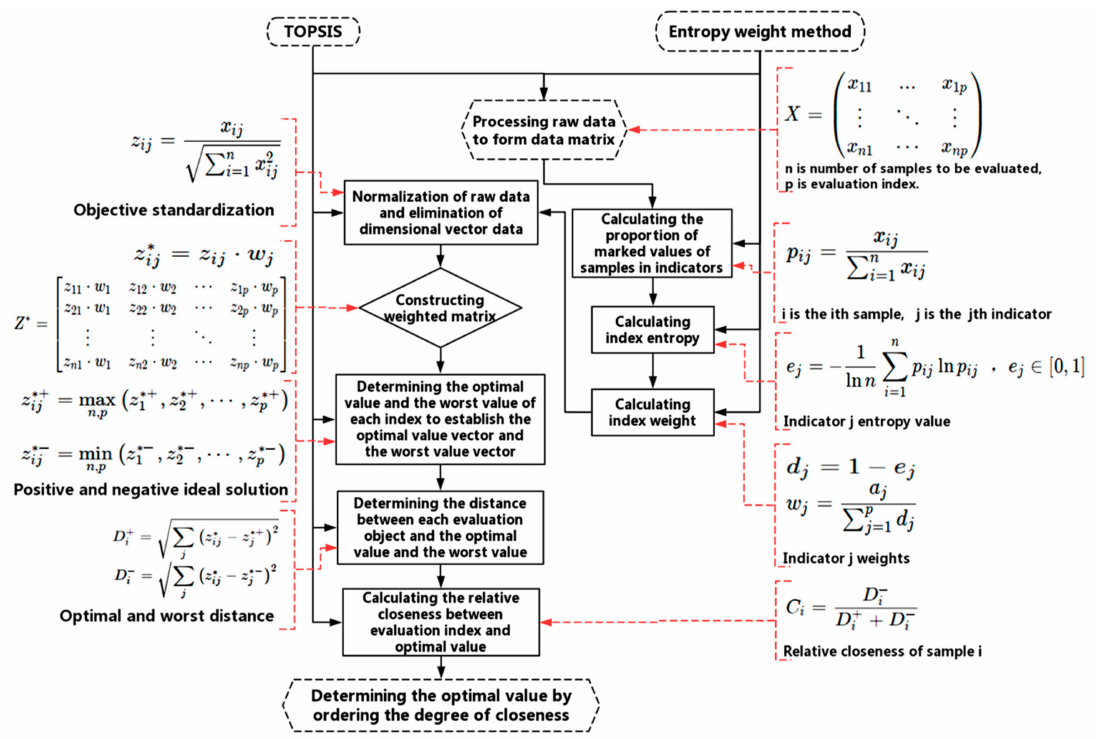
Figure 4. TOPSIS and entropy weight comprehensive decision